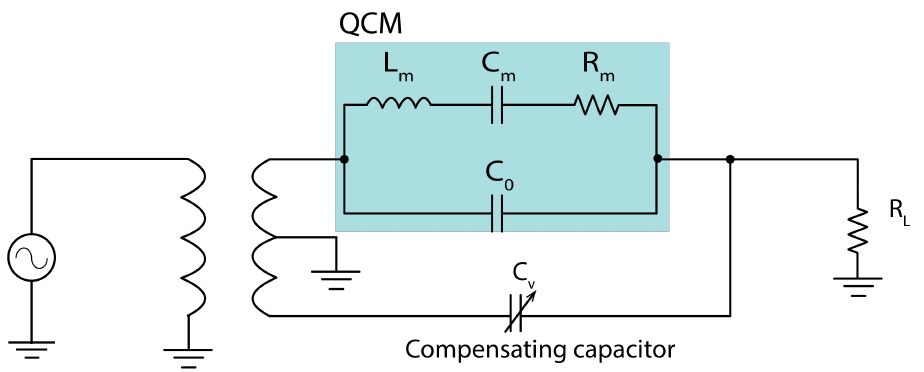
Figure 17. QCM oscillator with parallel capacitance